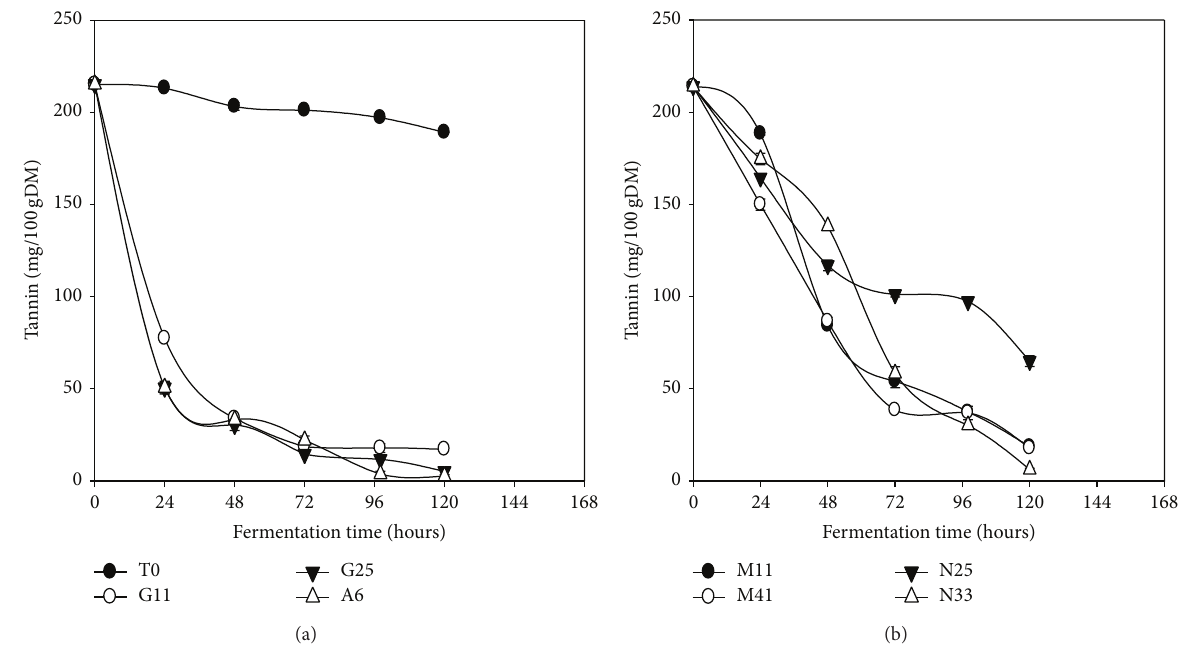
Figure 7: Evolution of the tannin content in Kutukutu during fermentation by the various LAB at 25 ∘ C (T0 = control; G11 = L. brevis G11; G25 = L. brevis G25; A6 = L. plantarum A6; M11 = L. buchneri M1; M41 = L. cellobiosus M41; N33 = L. fermentum N33; N25 = L. fermentum